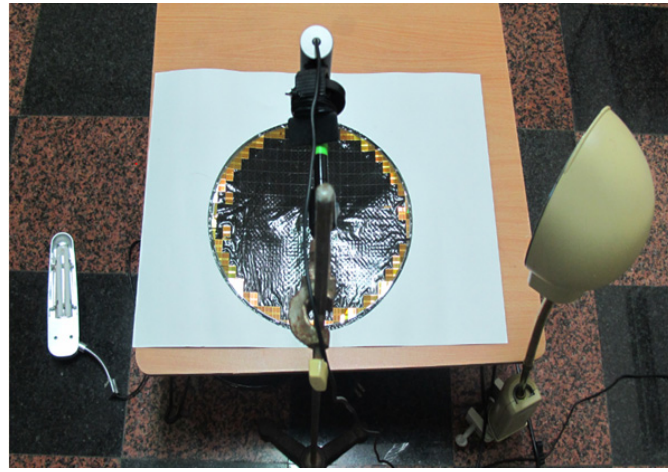
Figure 20. The experimental setup for taking the wafer images.